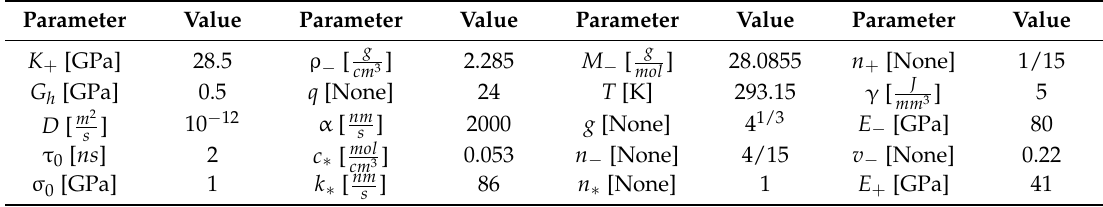
Table A1. Used parameters and their values of a two-phase Si